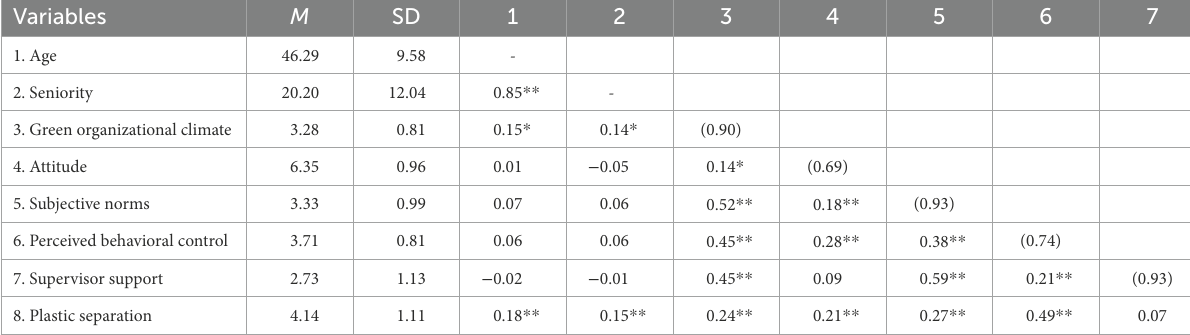
TABLE 2 Descriptive statistics, correlations, and reliabilities for plastic